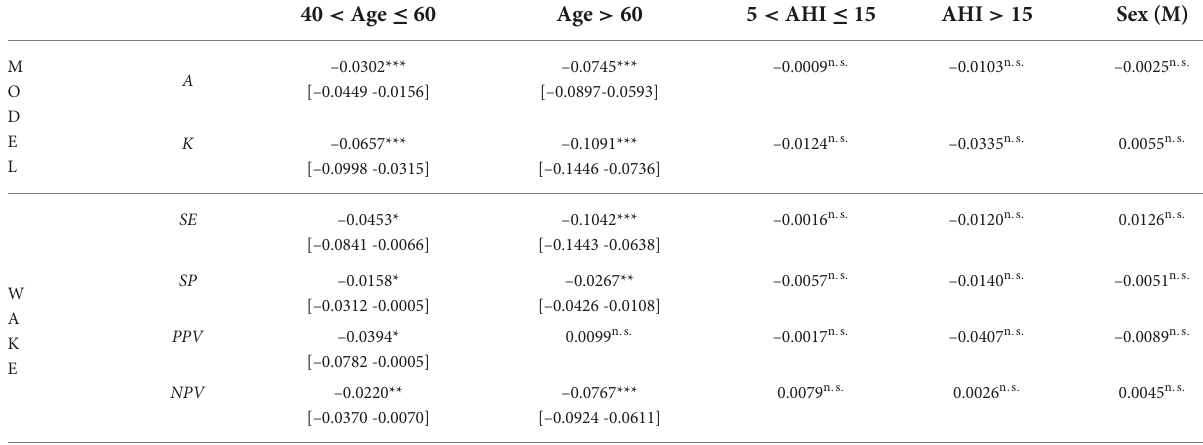
TABLE 3 Mean and [95% confidence intervals] of beta estimates of the performance of the 2-levels models as a function of the participants’ characteristics: age, AHI score, and biological